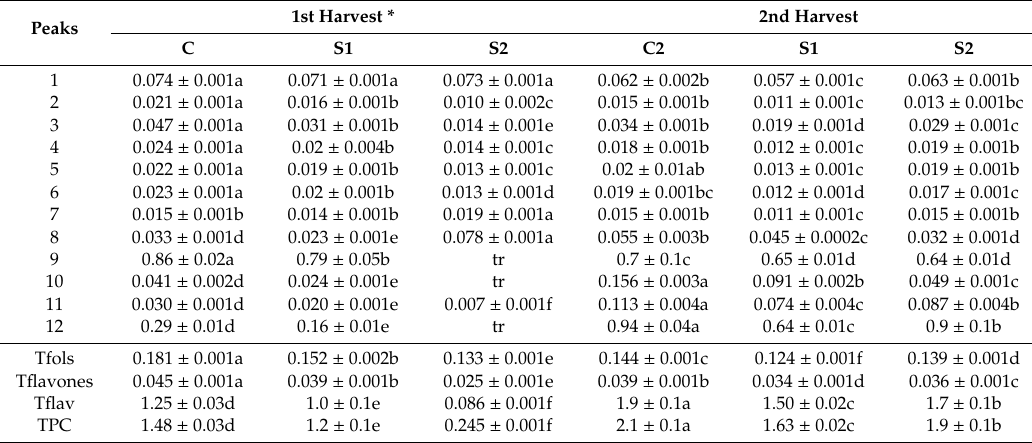
Table 8. Quantification (mg / g of plant fw) of the phenolic compounds present in the hydroethanolic extracts of Centaurea raphanina subsp. mixta leaves in relation to salinity level and harvesting time (mean ± SD, n =